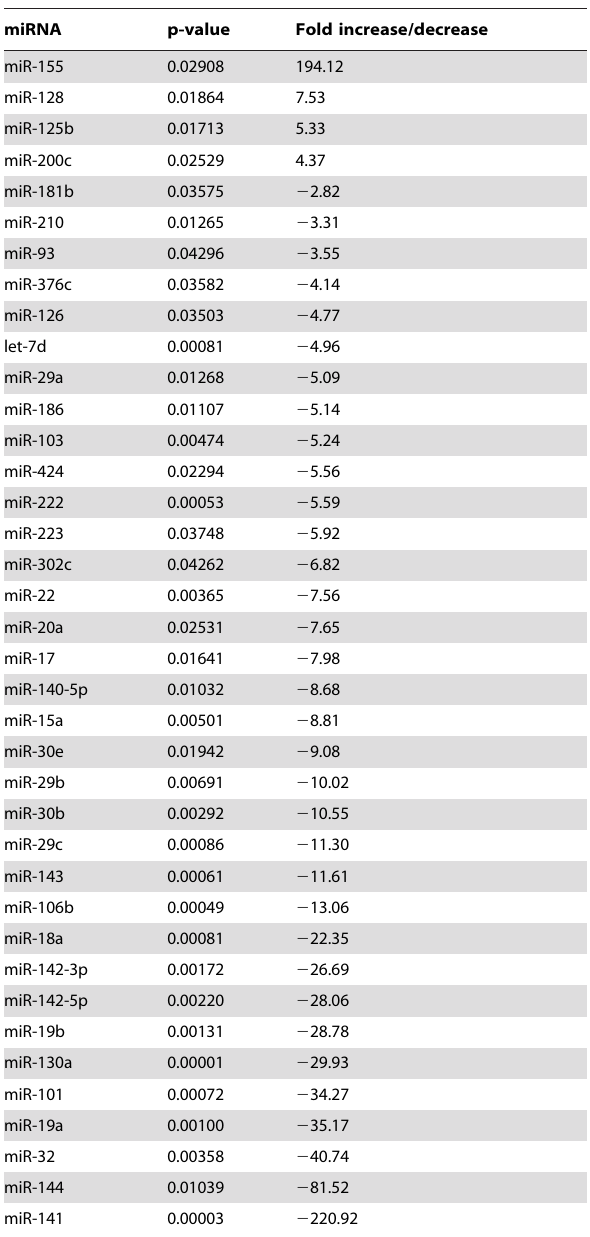
Table 2. List of increased and decreased miRNA in slowly progressive IPF biopsies (n=6) when compared to normal lung samples (n=10) with p # 0.05.